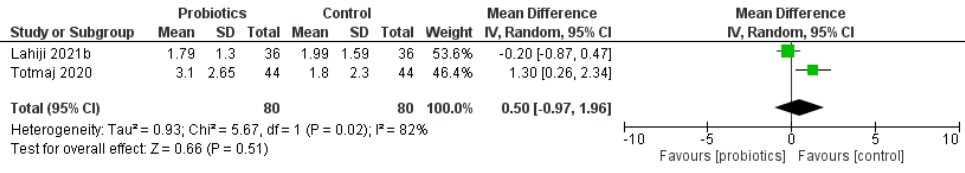
Figure 8. Meta-analysis for high-sensitivity C-reactive protein (hs-CRP).